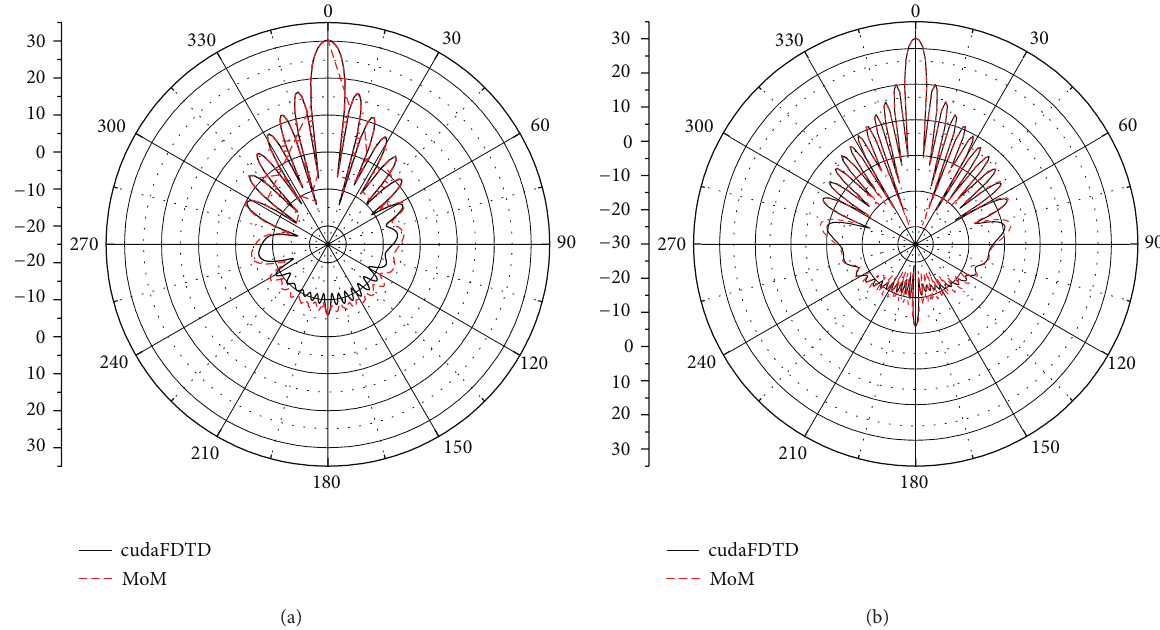
Figure 8: The radiation patterns of 𝑥𝑜𝑧 (a) and 𝑦𝑜𝑧 planes (b) of 16 × 18 mircostrip antenna array.